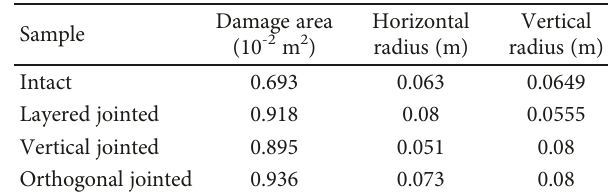
Table 2: Numerical results of the intact sample, layered jointed sample, vertical jointed sample, and orthogonal jointed sample under CO fracturing. 2